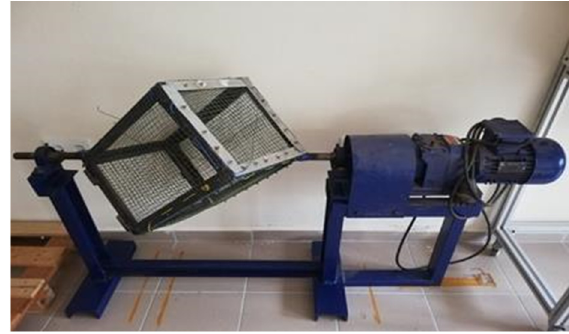
Figure 9. Tumbler test.